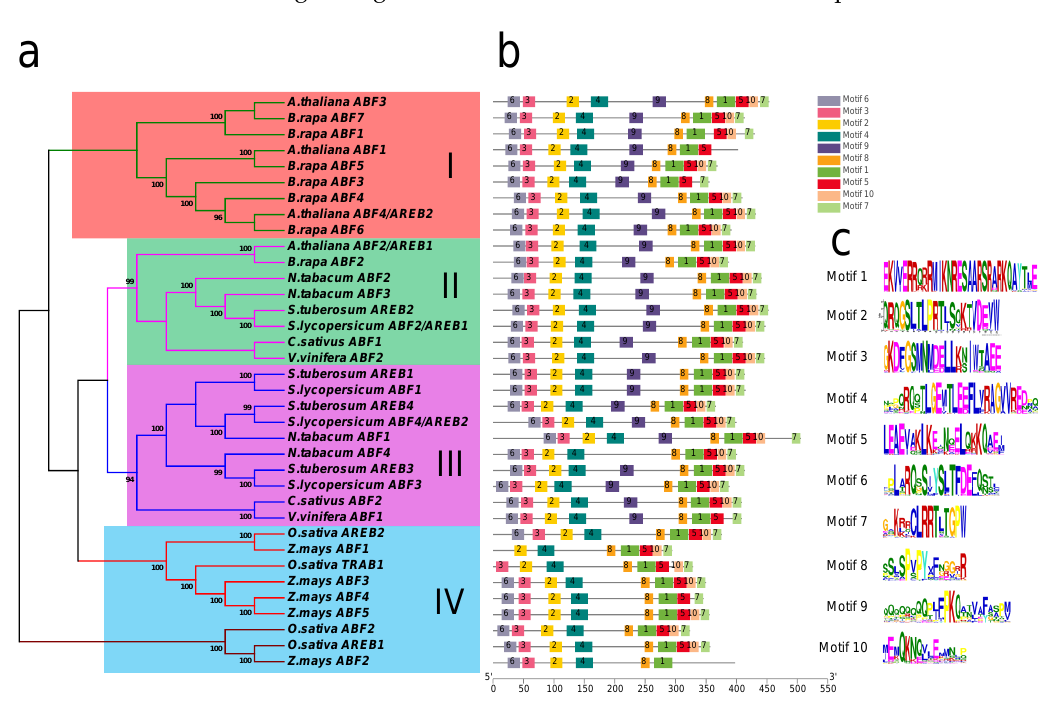
Figure 1. The phylogenetic tree and conserved motif analyses of SlABF/AREB proteins. ( a ) The phy- logenetic tree of ABF/AREB proteins in 9 plants, including Solanum lycopersicum , Solanum tuberosum , Cucumis sativus , Zea mays , Oryza sativa , Nicotiana tabacum , Vitis vinifera and Brassica rapa . ( b ) Con- served domains of the ABF/AREBs were analyzed and shown by MEME. ( c ) Sequence logos of the conserved motifs displayed by WebLogo.